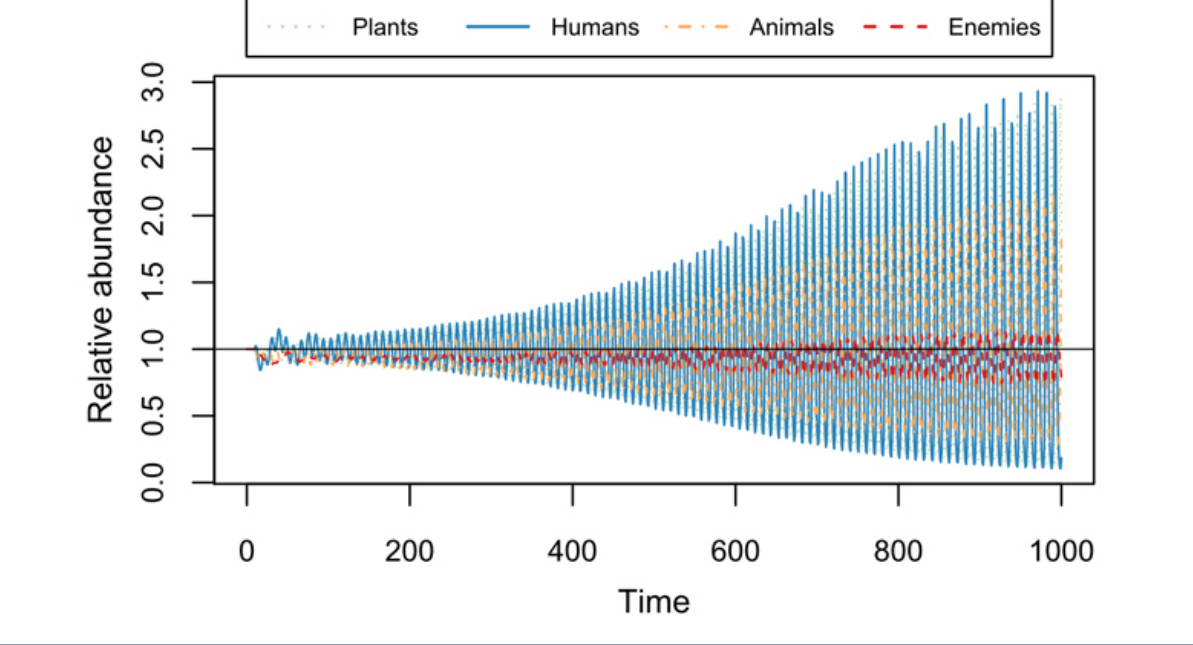
Fig. 4 . Effects of increased human consumption of plant resources on population dynamics. All state variables were at equilibrium from time 0 to 10, and are shown relative to these equilibrium values. Initial parameter values satisfied the feasibility conditions: c c = f = f = f = r = 1. At time 10, and thereafter, human consumption of plant resources was increased ( c pa he ah pa = 0.3), while other parameters remained constant values. This particular region of parameter space, and particular change in parameter values, corresponds to those previously considered for intraguild predation (Holt 1997, Holt and Polis